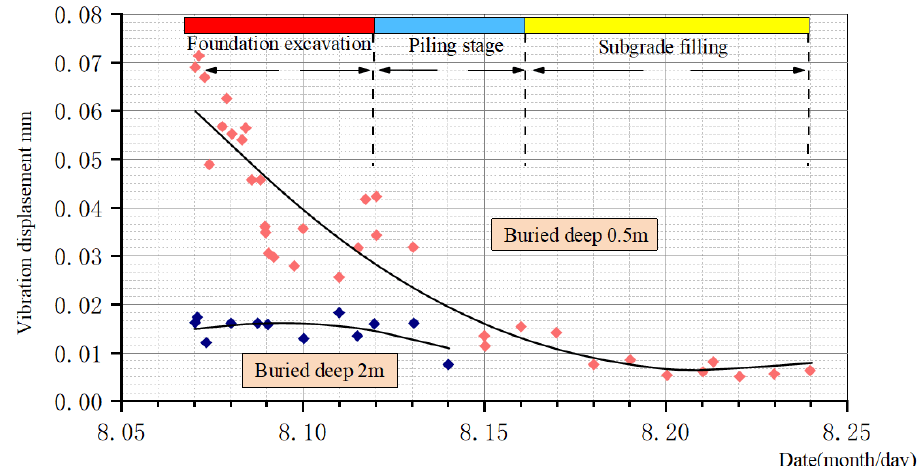
Figure 13. The vibration acceleration peak trend of different construction stage vibrations.